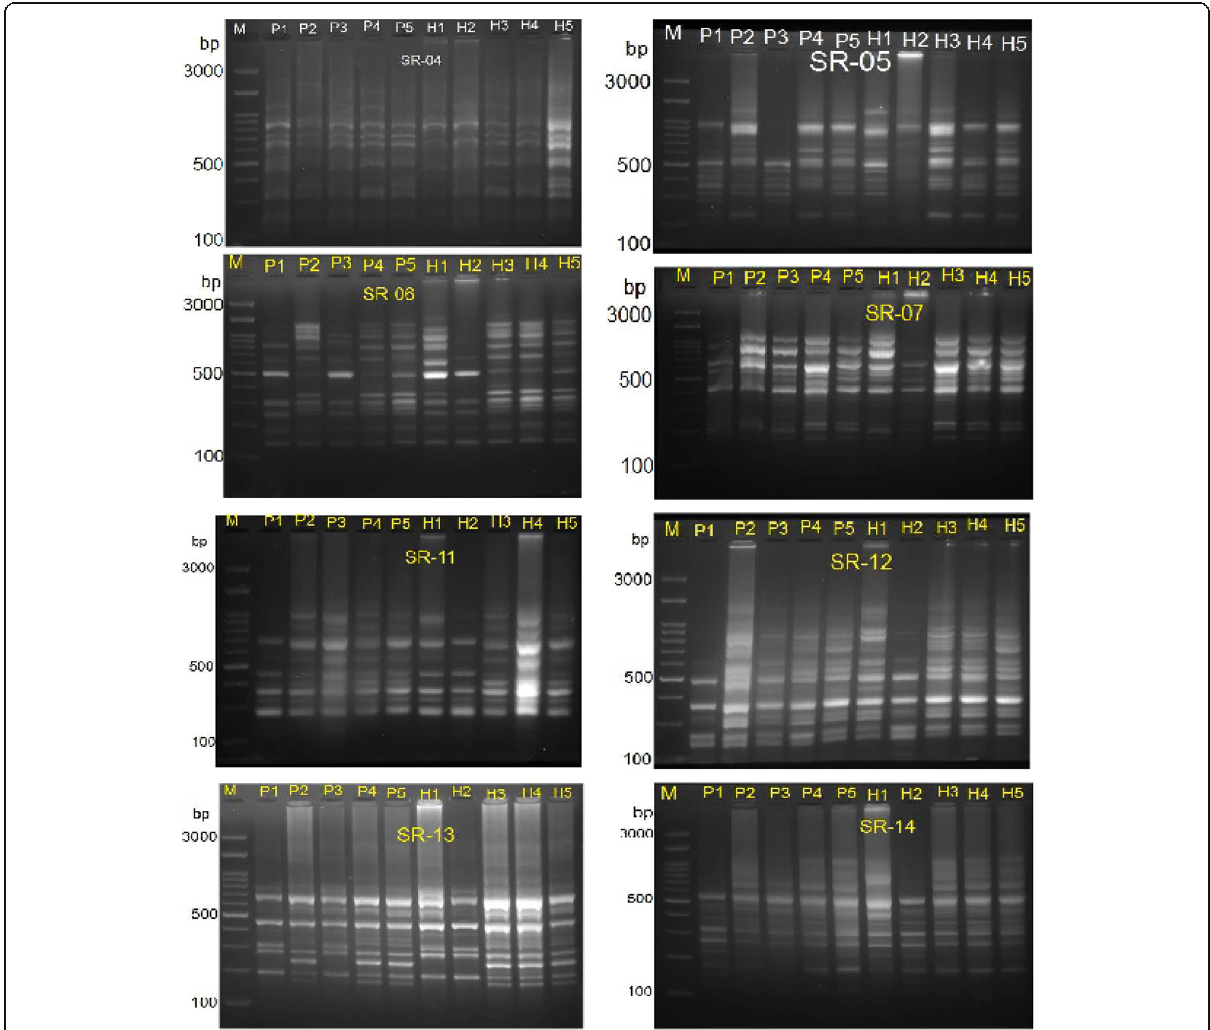
Fig. 1 PCRfragments with eight ISSR primers (SR-04, SR-05, SR-06, SR-07, SR-11, SR-12, SR-13, and SR-14) of ten sorghum entries (1:10) where P1: Line one (CYR3465-3-2), P2: Line two (Malzetar), P3: Giza 15, P4: Giza 113, P5: Dorado, H1: (P1 × P2), H2: ( P1 × P3), H3: (P2 × P3), H4: (P2 × P4), and H5: ( P3 × P4) M; DNA ladder (100 – 3000bp) as marker and the molecular weight as follows: 100, 200, 300, 400, 500, 600, 700, 800, 900, 1000, 1500, and 3000bp,